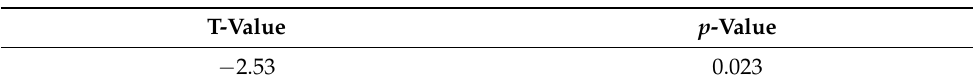
Table 14. Testing of significant